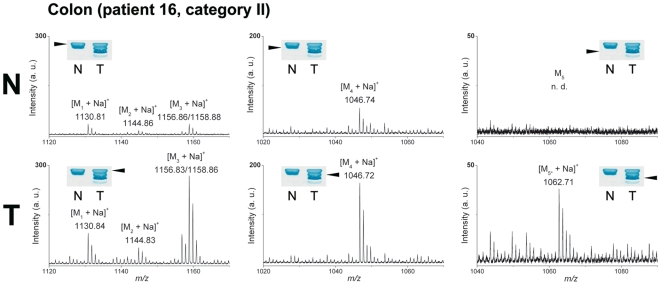
Tracing tumor-associated Gb3Cer/CD77 species in colon cancer.Lipid extracts equivalent to 2 mg wet weight of normal (N) and tumor tissue (T) of patient 16 (tumor category II, see Table 1 and Supplementary Table S2) were simultaneously separated by TLC followed by overlay analysis using Stx1. The Stx1 positive Gb3Cer bands, which are marked with arrowheads in the insets, were analyzed by TLC-IR-MALDI-MS. The prevalent [M3+Na]+ molecular ions of the upper band of the tumor tissue (T, left panel) correspond to Gb3Cer (d18:1, C24:1/C24:0) and the less abundant [M2+Na]+ and [M1+Na]+ ions to Gb3Cer (d18:1, C23:0) and Gb3Cer (d18:1, C22:0), respectively. In the upper band of normal tissue (N, left panel) much lower intensities of corresponding molecular ions were observed. The strong [M4+Na]+ ions of the lower band in the tumor (T, middle panel) represent Gb3Cer (d18:1, C16:0), which is detectable only in low quantities in normal tissue (N, middle panel). Analysis of the lowest band of the tumor (T, right panel) revealed [M5*+Na]+ ions, which are indicative for hydroxylated Gb3Cer (d18:1, h16:0). This Gb3Cer/CD77 variant was undetectable in normal tissue (N, right panel). The m/z values of molecular ions and proposed structures of Gb3Cer/CD77-variants of malignant and adjacent normal tissues as well as references from human erythrocytes are listed in Supplementary Table S3.